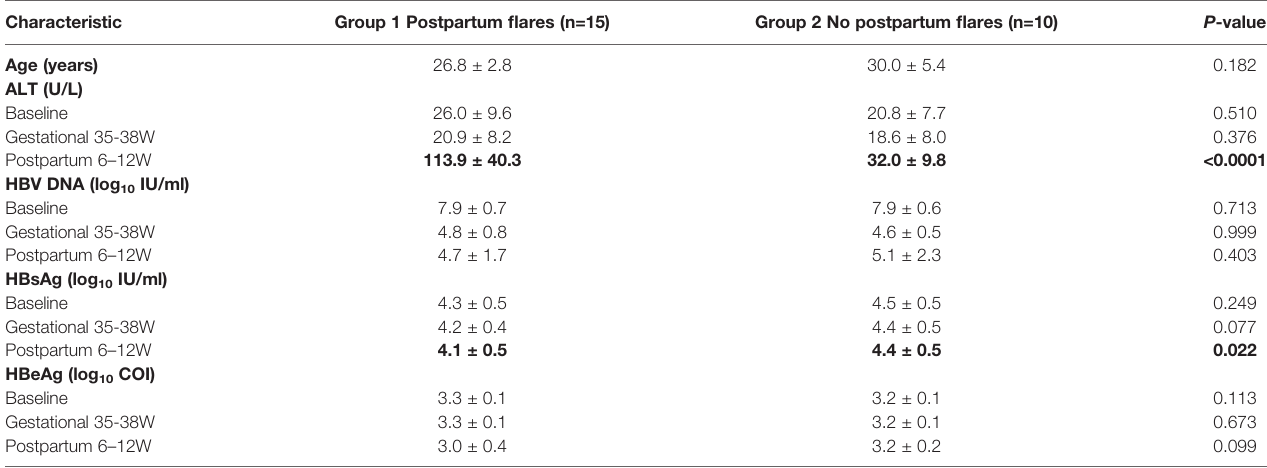
TABLE 1 | Characteristics of all subjects with and without postpartum hepatic fl ares.